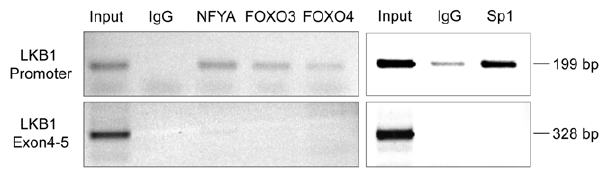
Figure 6. Chromatin immunoprecipitation (ChIP) analysis of NF-Y, FOXO3 and FOXO4 binding at the LKB1 promoter. Enrichment of PCR products specific for the LKB1 promoter region (upper panel) in comparison to PCR products specific for the LKB1 coding region encompassing exon 4–5 (lower panel). PCR products were amplified from sonified DNA after ChIP, subsequently run on a 1% agarose gel and stained with ethidium bromide. As a positive control (Input), 1/10 of the starting material was used for PCR. Protein-DNA complexes were either incubated with non-specific goat IgG (negative control) or with antibodies against the transcription factors NFY- a , Sp1 (sc-14027 X), FOXO3 or FOXO4. The figure shows a representative of three independent experiments.